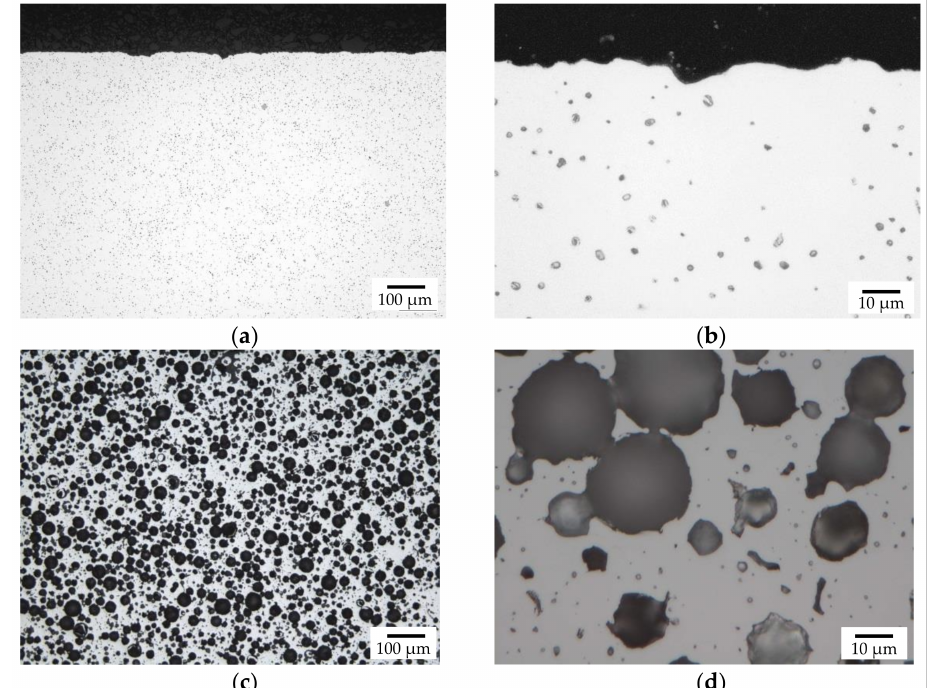
Figure 2. Macroscopic overview of the polished section of an as-sintered sample without hollow, ( a , b ) and with spheres ( c , d ).